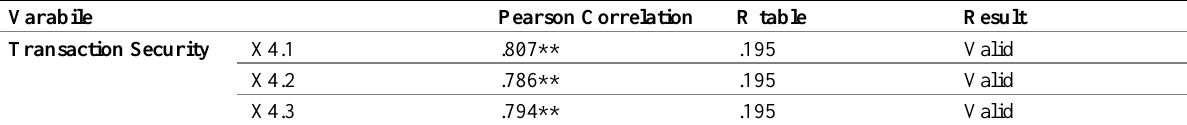
Table 5: Transaction Security Validity Test